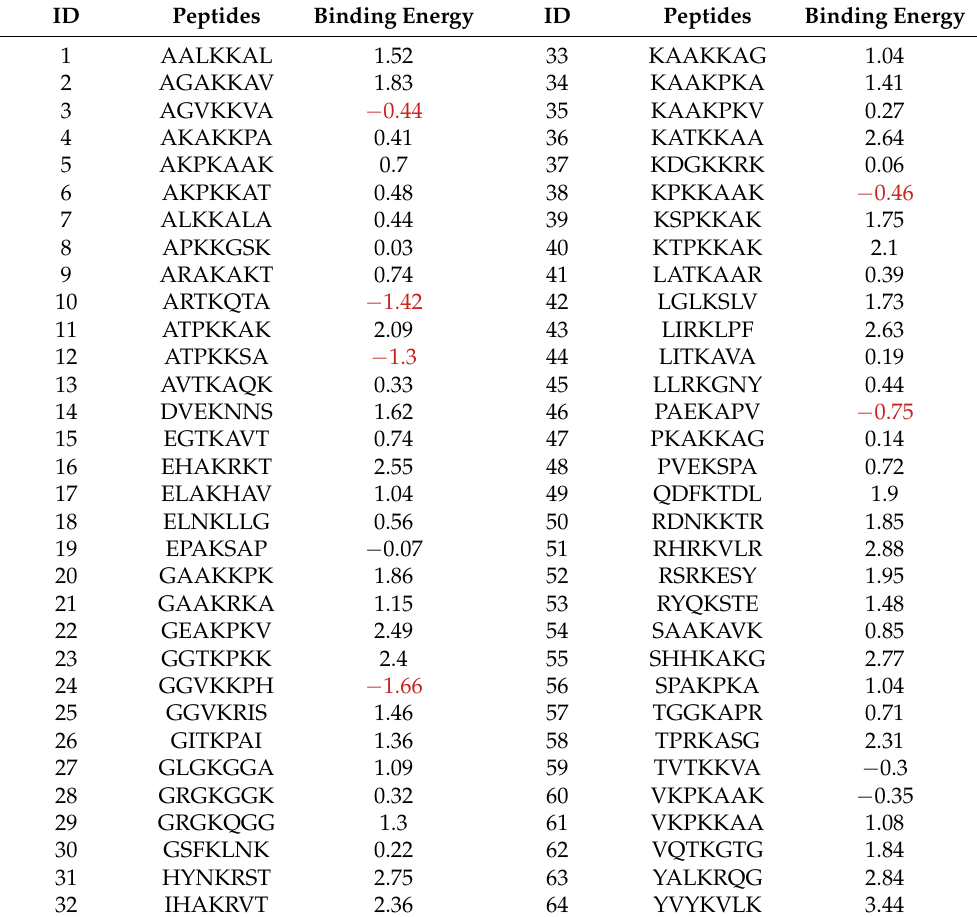
Table 1. The binding energy between 64 histone-based peptides and PRDM15.